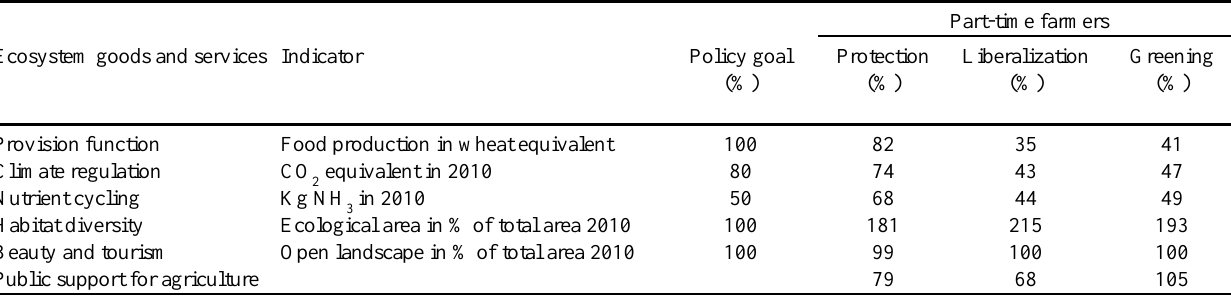
Part-time farmers Protection Liberalization Greening (%) (%) (%) (%)